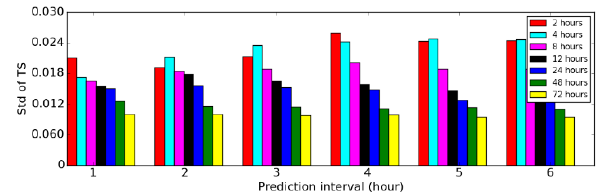
Figure 8.The standard deviation of TS scores about different hours time scale SVM for all